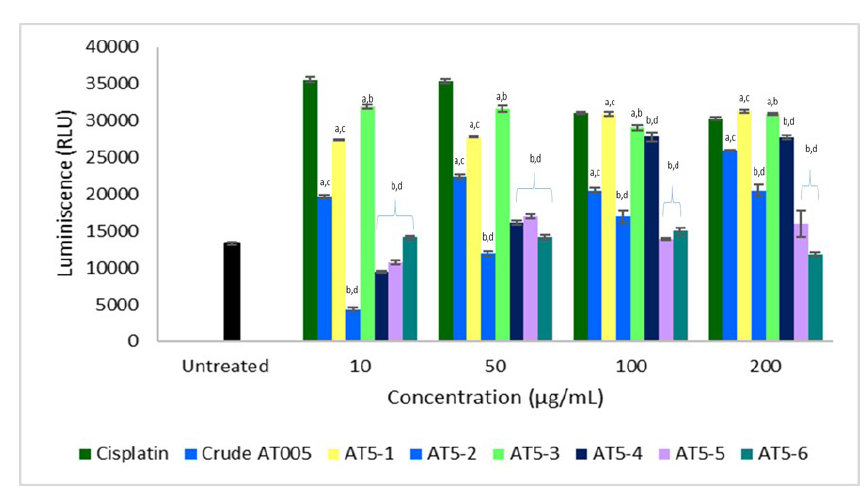
Figure 5. Caspase 3/7 activation of Phlogiellus bundokalbo crude spider venom and its fractions after 48-hour incubation in contrast with cisplatin. Averaged value from three trials with triplicate readings. Different letters indicate significant differences (p < 0.05).